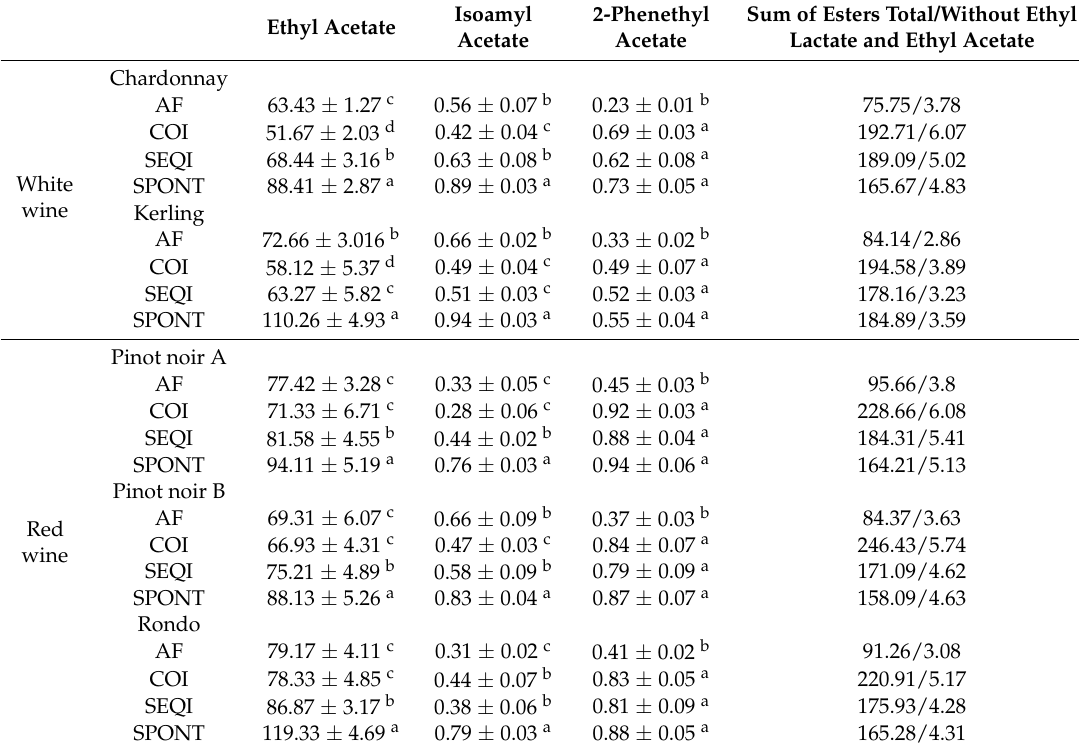
Table 3. Concentrations (mg/L) of esters in white and red grape wines produced by different methods of MLF induction; parameters were evaluated three months after bottling Sum of Esters Total/Without Ethyl Ethyl Acetate Lactate and Ethyl